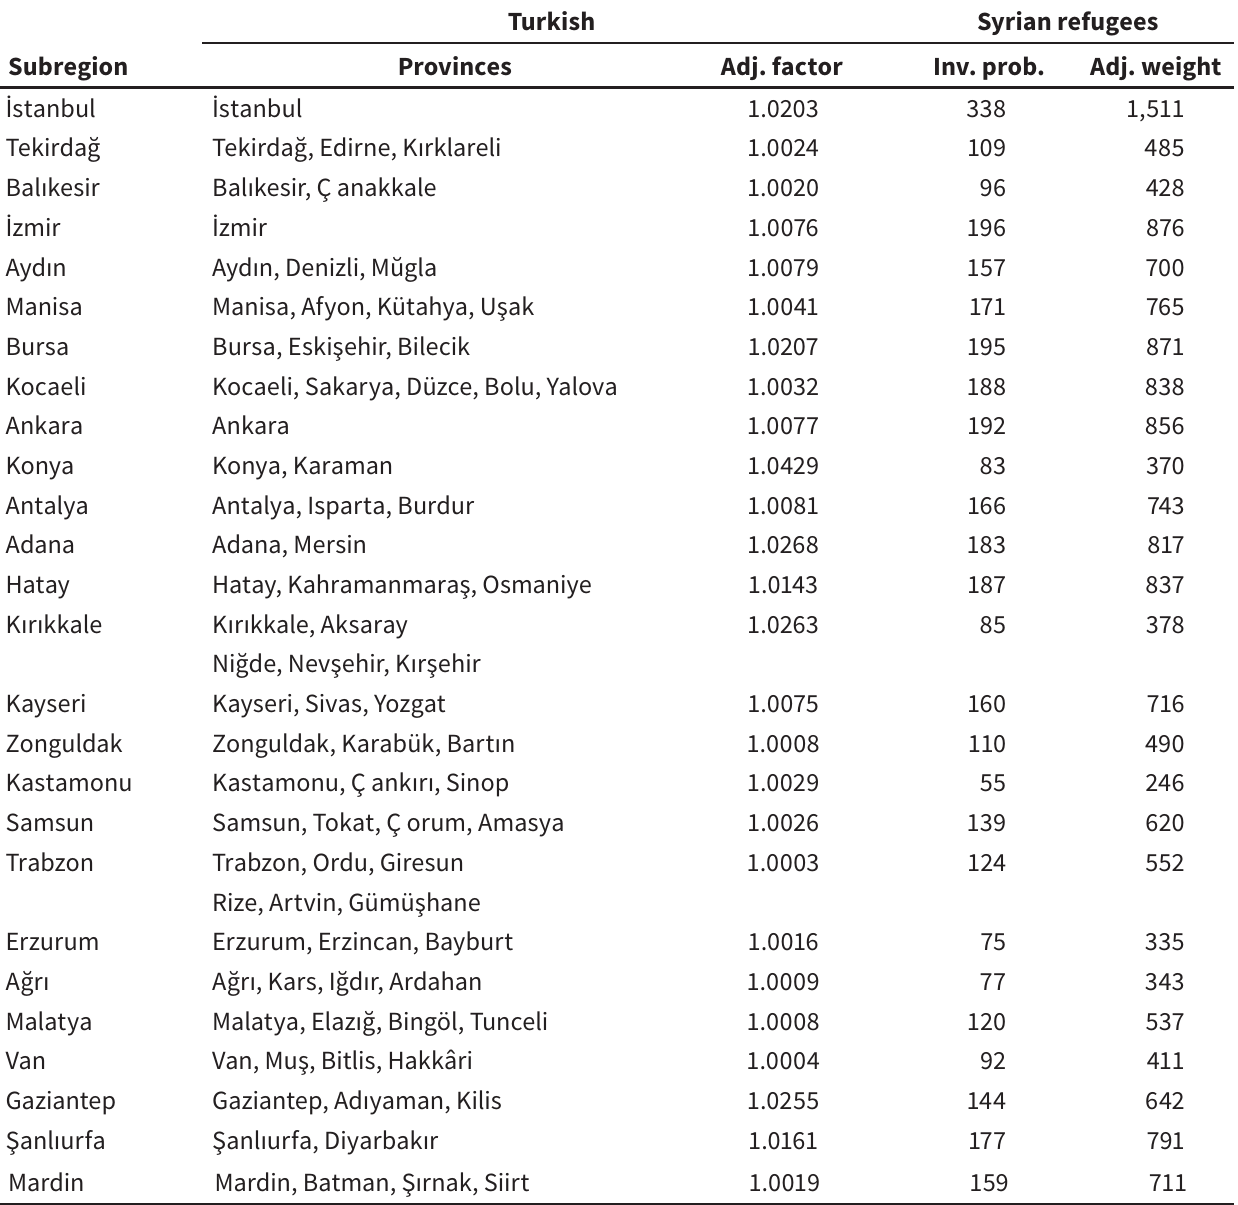
Re-weighting by subregion (NUTS-2), 2017